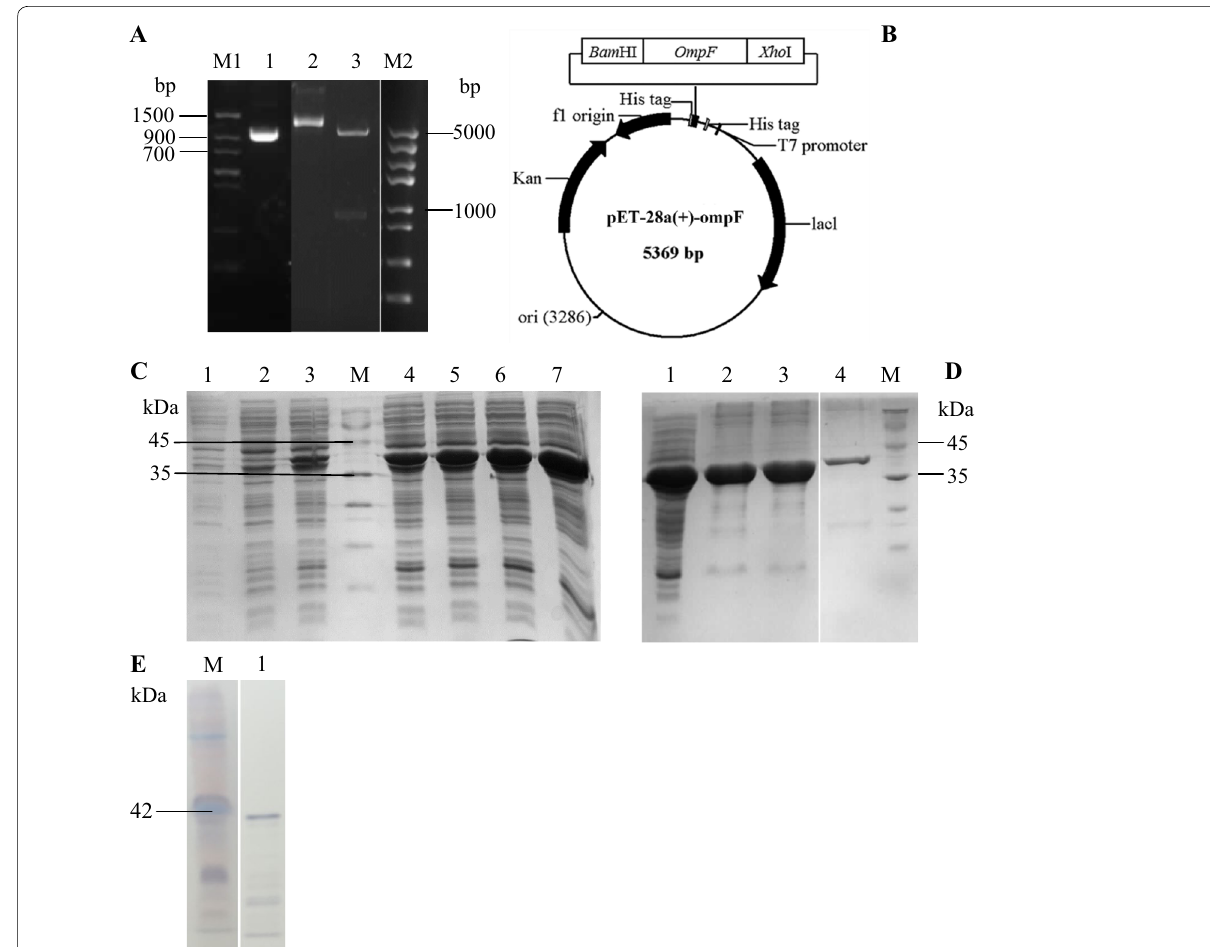
Fig. 3 Cloning, expression, purification and Western blotting analysis of OmpF. aA PCR products of the ompF gene. Lane M1 Trans DNA Marker II (1500, 900, 700, 500, 400, 200 and 100 bp); lane 1 ompF PCR products. Lane 2 the recombinant pET-28a( )-ompF plasmid. Lane 3 the recombinant + pET-28a( )-ompF plasmid digested with BamH I and Xho I; lane M2 Trans 5K DNA Marker (5000, 3000, 2000, 1500, 1000, 800, 500 and 300 bp); B + schematic representation of the pET-28a( )-ompF plasmid; C SDS-PAGE analysis of the expression of rOmpF in auto-inducing media at differ- + ent time. 1 mL of cultured cells were collected at 4, 6, 8, 10, 12, 14, and 24 h, respectively. Lane M protein marker (94.4–14.4 kDa); lane 1 4 h;